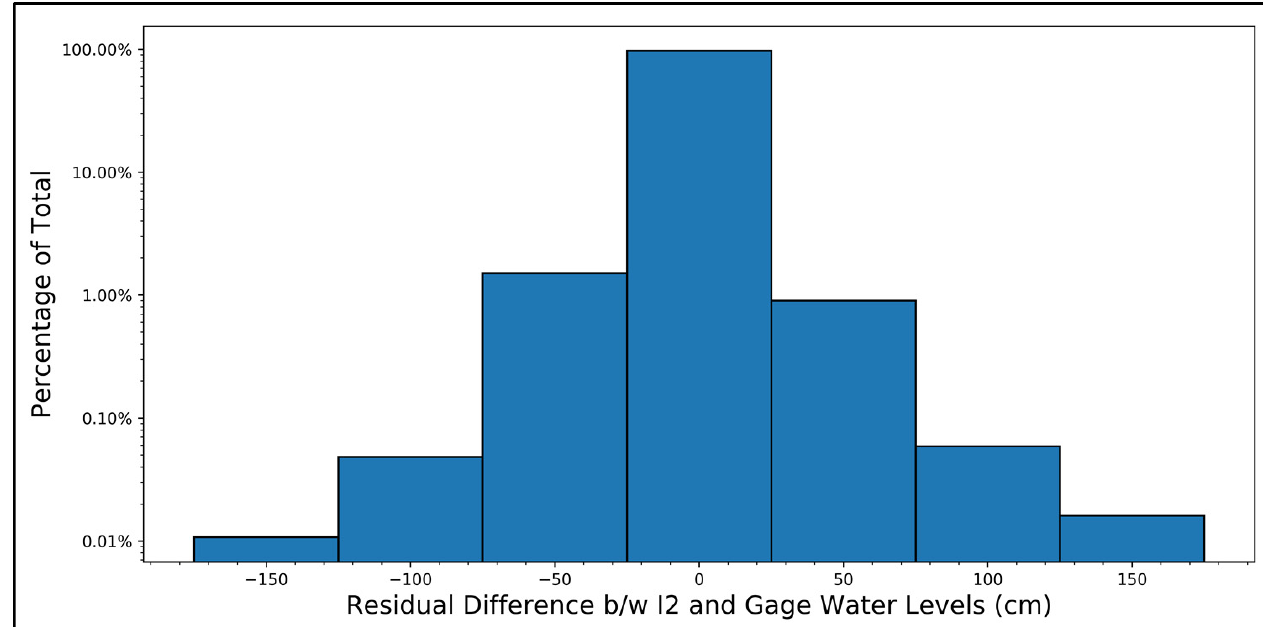
Figure 6. Frequency histogram of the residual differences from the “strong” beam IS-2 and gaged relative water level changes. Each bin is 50 cm wide and is centered on the 0 cm residual difference. Note that the y -axis unit is the percentage of IS-2 and gaged comparisons with residual water level differences within each particular bin’s range. The y -axis is on a base 10 logarithmic scale in order to show the lower frequency bins at the tails. The IS-2 water level changes are from the ATLAS “strong” beams